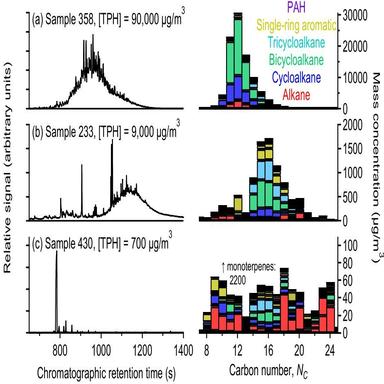
Chromatograms (left) and composition distribution (right) of three representative field samples, numbered as in complete dataset. Composition is a stacked plot, colored as labeled and in the bottom-to-top order: NDBE = 0 is red with n-alkanes darker, NDBE = 1 is blue with n-alkycyclohexane darker, NDBE = 2 is green, NDBE = 3 is teal, NDBE = 4–6 are yellows, NDBE = 7–8 are purple (For interpretation of the references to colour in this figure legend, the reader is referred to the web version of this article)